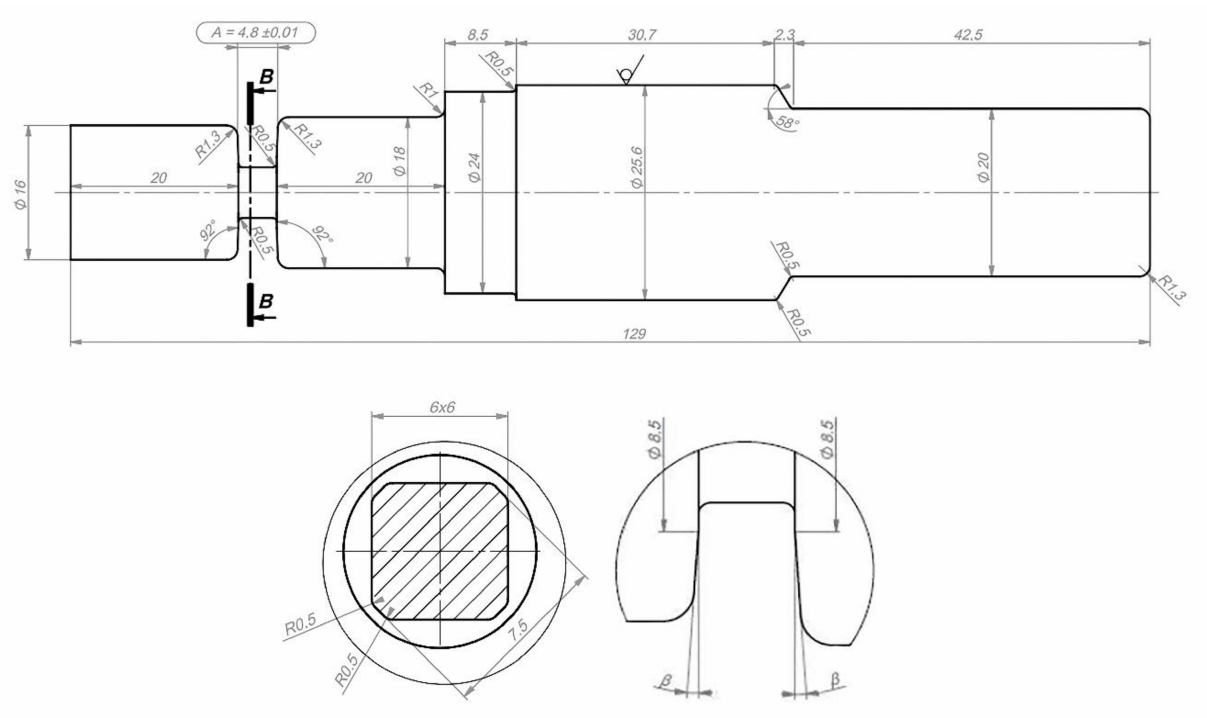
Figure 4. Tools used: in tool A2, β 1 = 2 ◦ ; in tool A4, β 2 = 4 ◦ (All units in are in